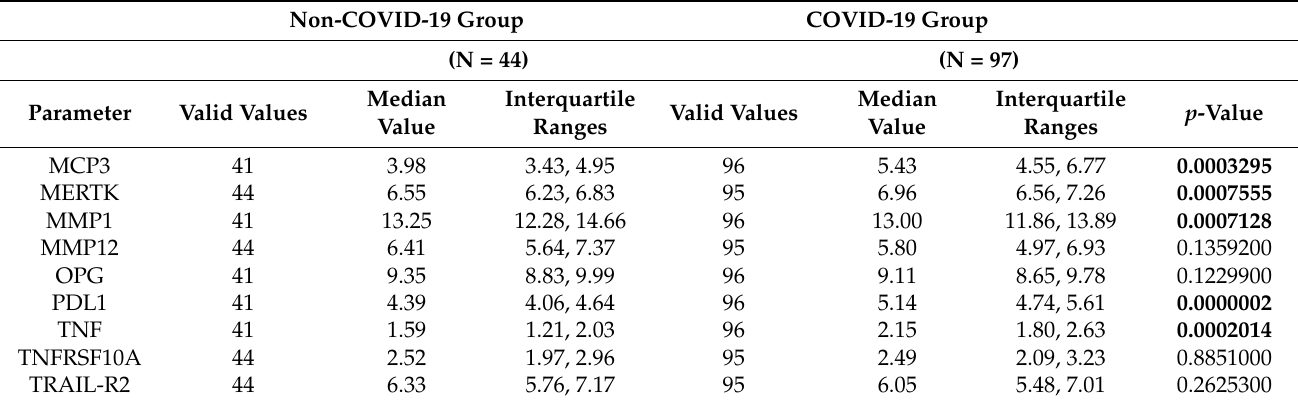
Table 2. Levels of selected circulating proteins and standard of care parameter (SoC) levels, interquartile ranges and significances ( p -values) of the COVID-19 group with regard to the clinical endpoints hospitalization, intensive care unit (ICU) treatment, indication for mechanical ventilation (MV), thromboembolic event (TE), and death. Only analytes with significant discrimination either between non-COVID-19 and COVID-19 patients, or within hospitalized and non- hospitalized COVID-19 patients are shown. Only p -values < 0.001 are depicted in bold. Median and Interquartile Ranges for Median and Interquartile Ranges for Non-Outcomes